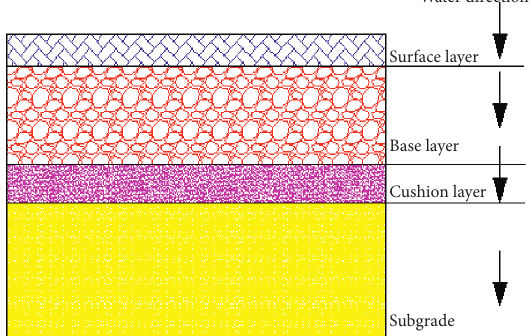
Figure 5: Permeable road